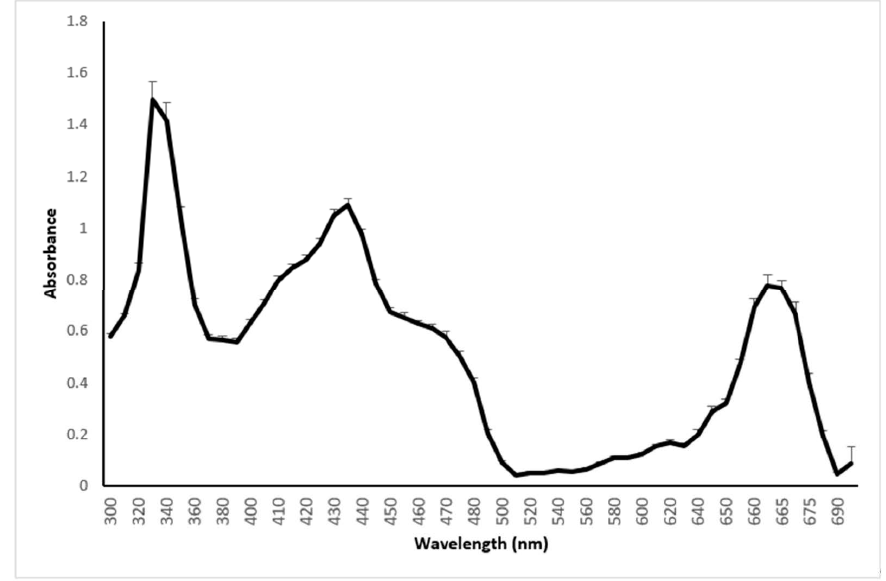
Figure 3. Spectrometric analysis of sweet basil ( Ocimum basilicum ) pigment absorption using a Jenway 7315 spectrophotometer: Results are presented as means + standard error (S.E.).